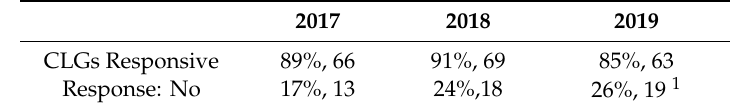
Table 1. Responses to Question 15: Do the members of the Preservation Commission represent the general ethnic diversity of the